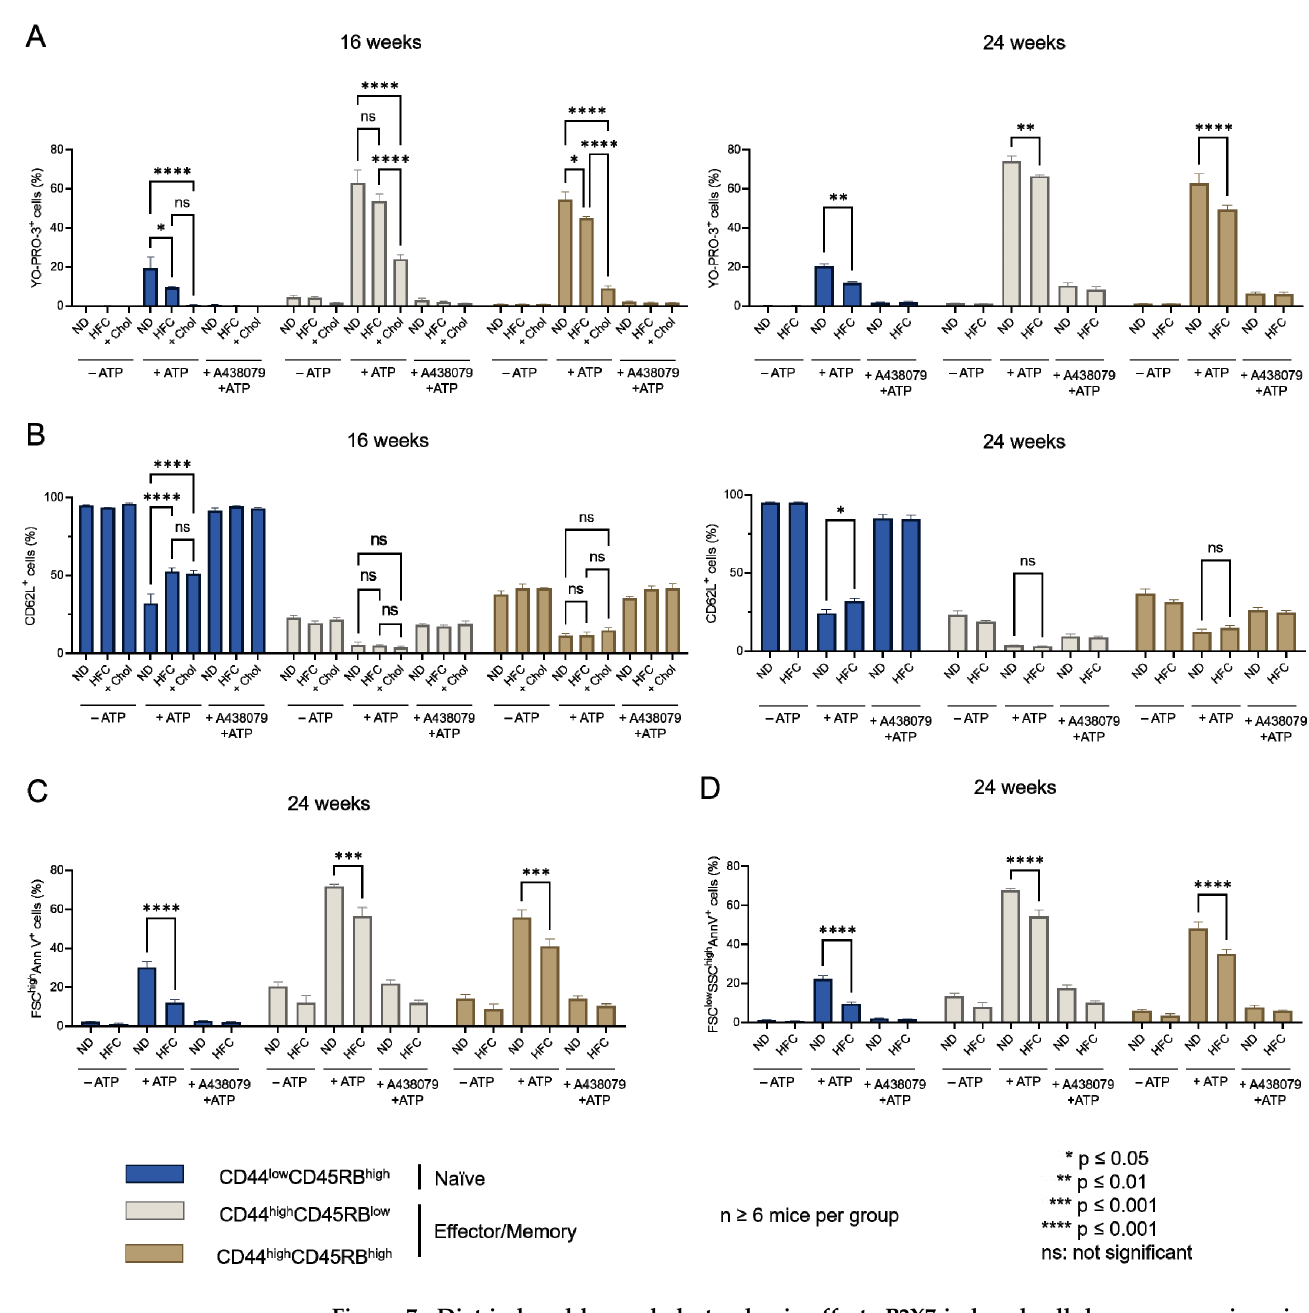
Figure 7. Diet-induced hypercholesterolemia affects P2X7-induced cellular responses in naive and effector/memory CD4 + T cells. Following stimulation with 500 µM eATP for 30 min at 37 °C with or without pre-treatment with 10 µM of the P2X7 antagonist A438079 (+A438079), P2X7-dependent pore formation ( A ), CD62L shedding ( B ), reversible PS externalization in liv- ing cells (FSC high AnnV + ) ( C ), and cell death characterized by irreversible PS externalisation (FSC low SSC high AnnV + ) ( D ) were evaluated in CD44 low CD45RB high naive and CD44 high CD45RB high